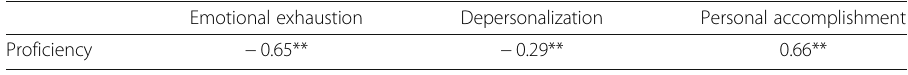
Table 2 Correlations between the proficiency and burnout dimensions Emotional exhaustion Depersonalization